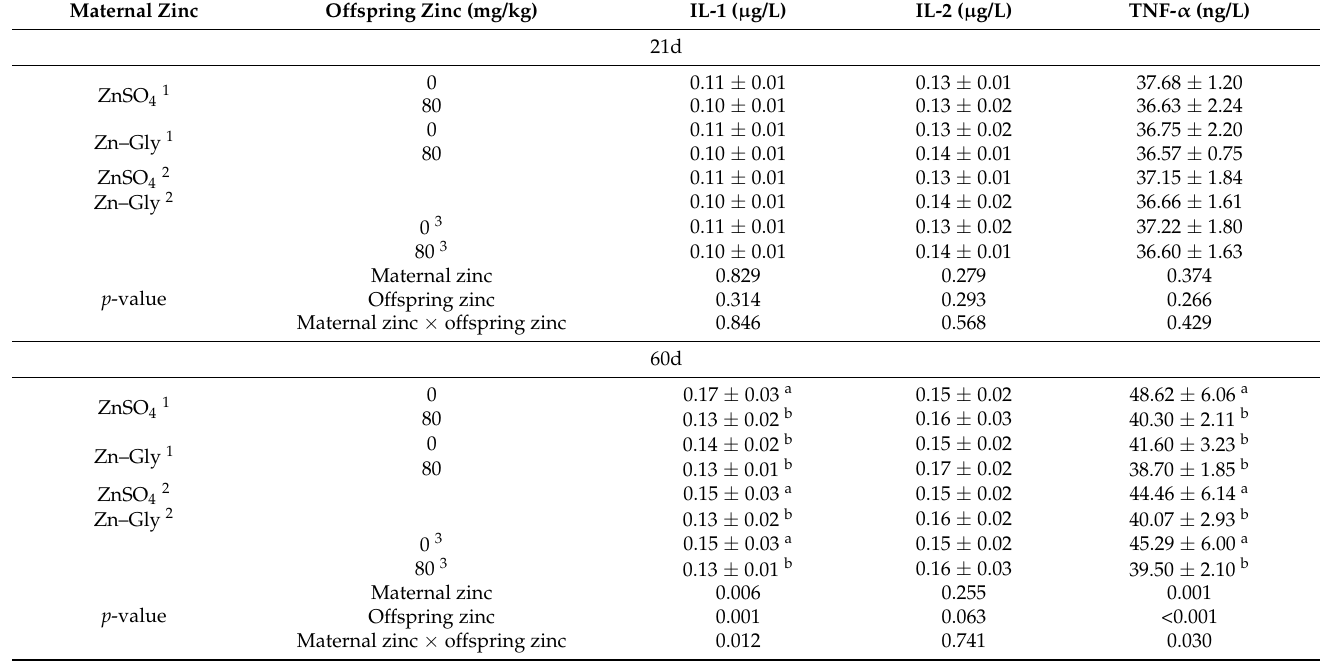
Table 8. Effects of maternal Zn in conjunction with their offspring dietary Zn supplementation on cytokine secretion in serum of offspring broilers (mean ± S.E.).